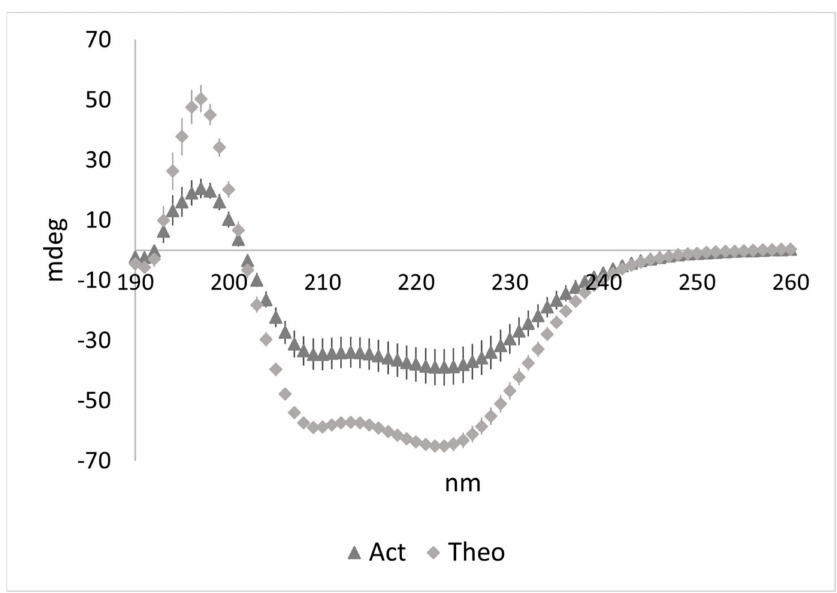
Figure 3. Actual experimental output of LMMWYR compared to the Theoretical output expected for a nonbinding LMM+WYR combination supports binding of LMM and WYR. N = 6. Each symbol represents mean ±